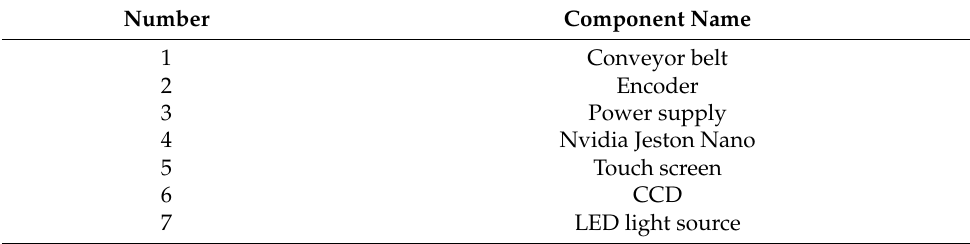
Figure 9. Edge surface defect detection system. Table 4. Serial number and name of component in detection system.